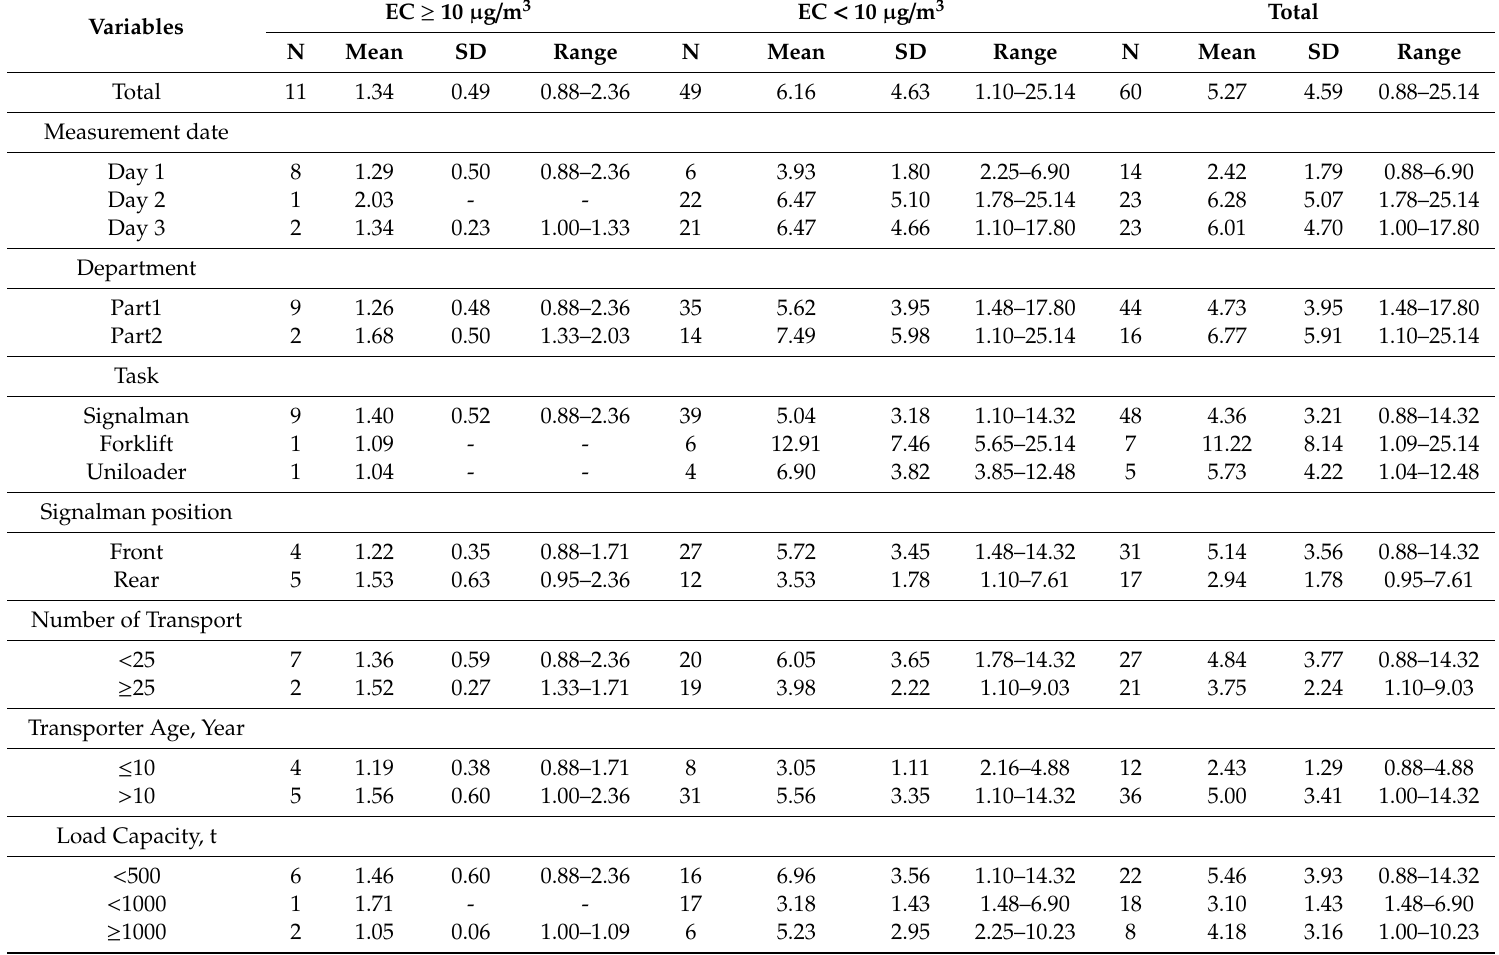
Table 4. Ratio of OC / EC by EC exposure level and